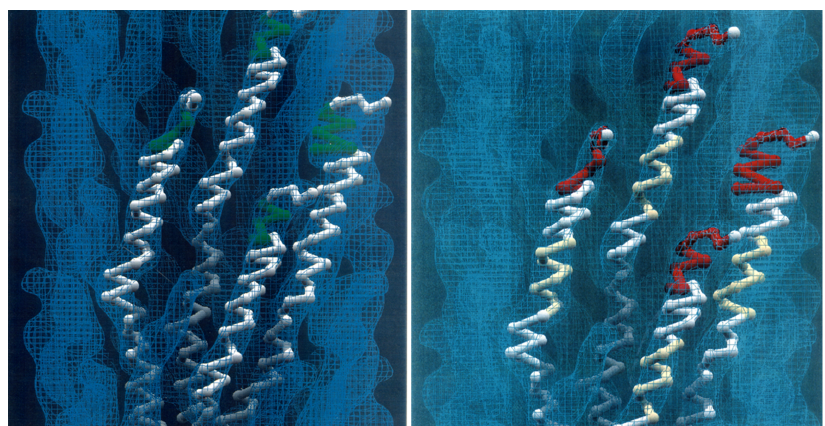
Figure 7. Models of landscape-phage libraries. Left : Ball-and-stick model of four neighboring pVIII proteins with inserted 5-mer peptides (green). About 1% of the phage length is shown. Right : Ball-and-stick model of three neighboring pVIII proteins with N-terminal random foreign 8-mer peptides (red) and mutagenized central segments (yellow) on the surface of the phage capsid (blue contour). The courtesy of Lee Makowski and Gregory Kishchenko.